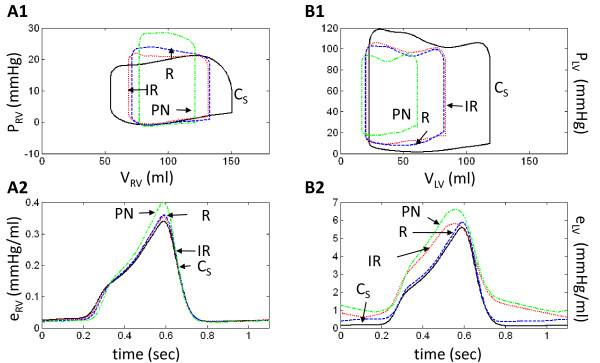
Model Ventricular Function Curves - Increased LV Systolic Contractility. Model-generated ventricular function curves of LVDD with increased LV systolic contractility. Abbreviations are as in Figure 3. CS represents a new elastance control curve where the ESPVR contractility has been augmented, but no other changes have been made.